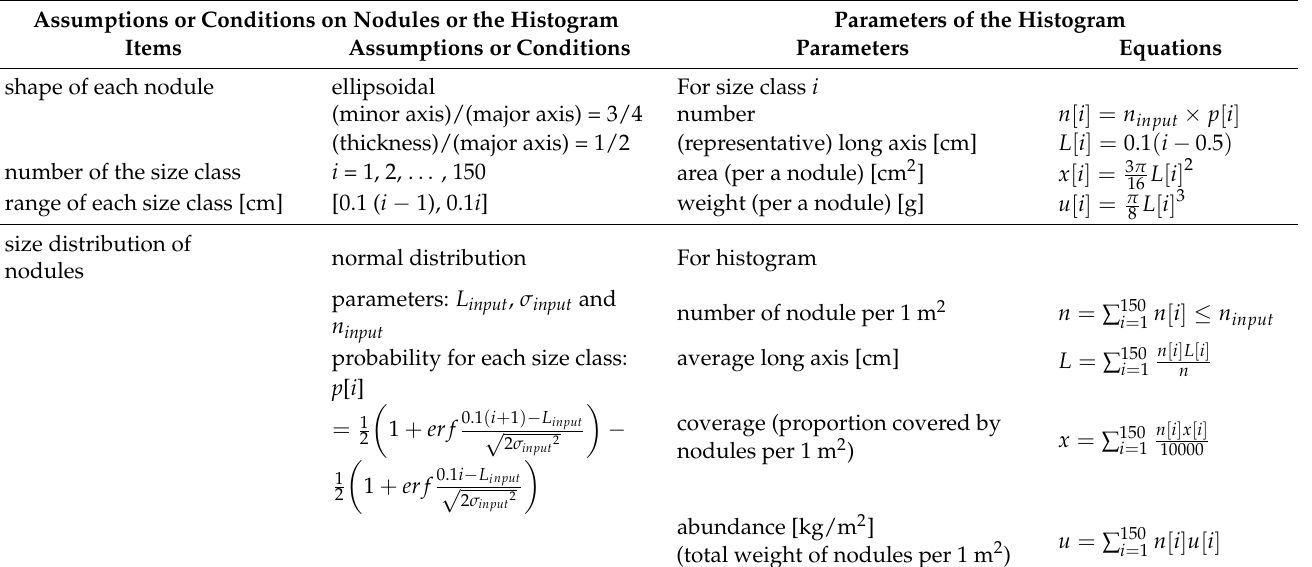
Table 1. Calculation conditions, assumptions and parameters of the histogram used in this paper. Assumptions or Conditions on Nodules or the Histogram Parameters of the Histogram Assumptions or Conditions Parameters